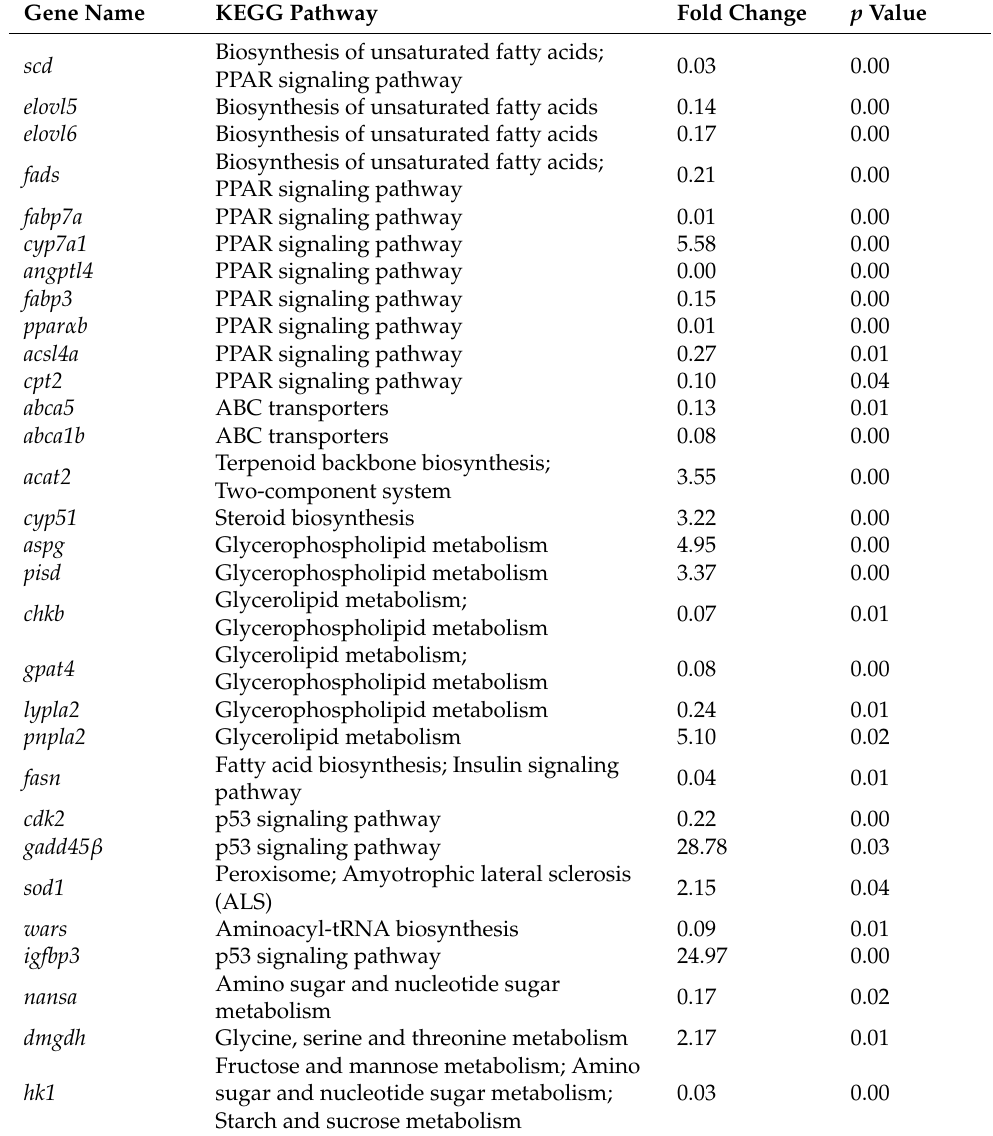
Table 5. DEGs enriched in KEGG